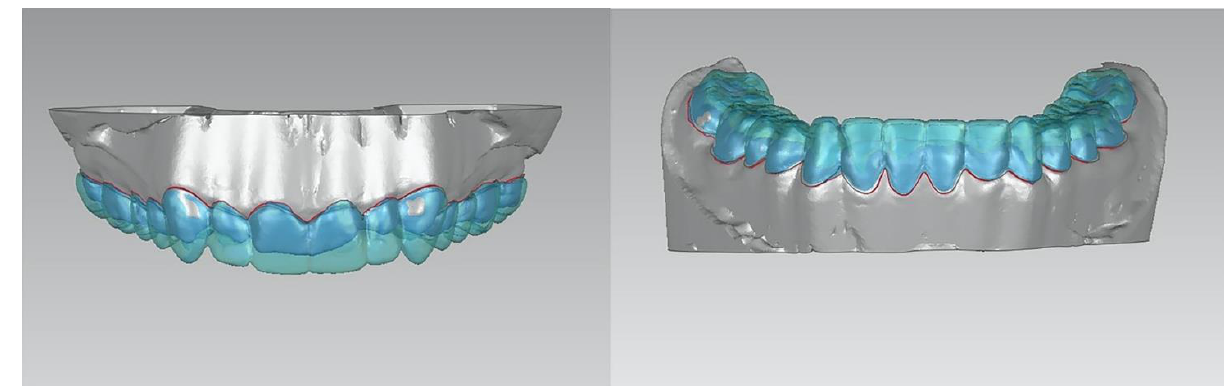
Figure 7. Case 3—Dental arches of a young patient with amelogenesis imperfecta.